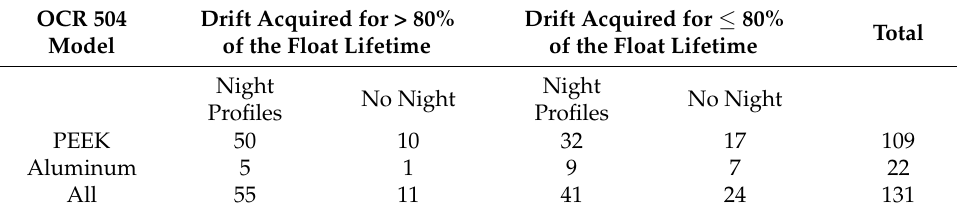
Table 1. Availability of night profiles and daily drift measurements for the 55 and 76 BGC-Argo